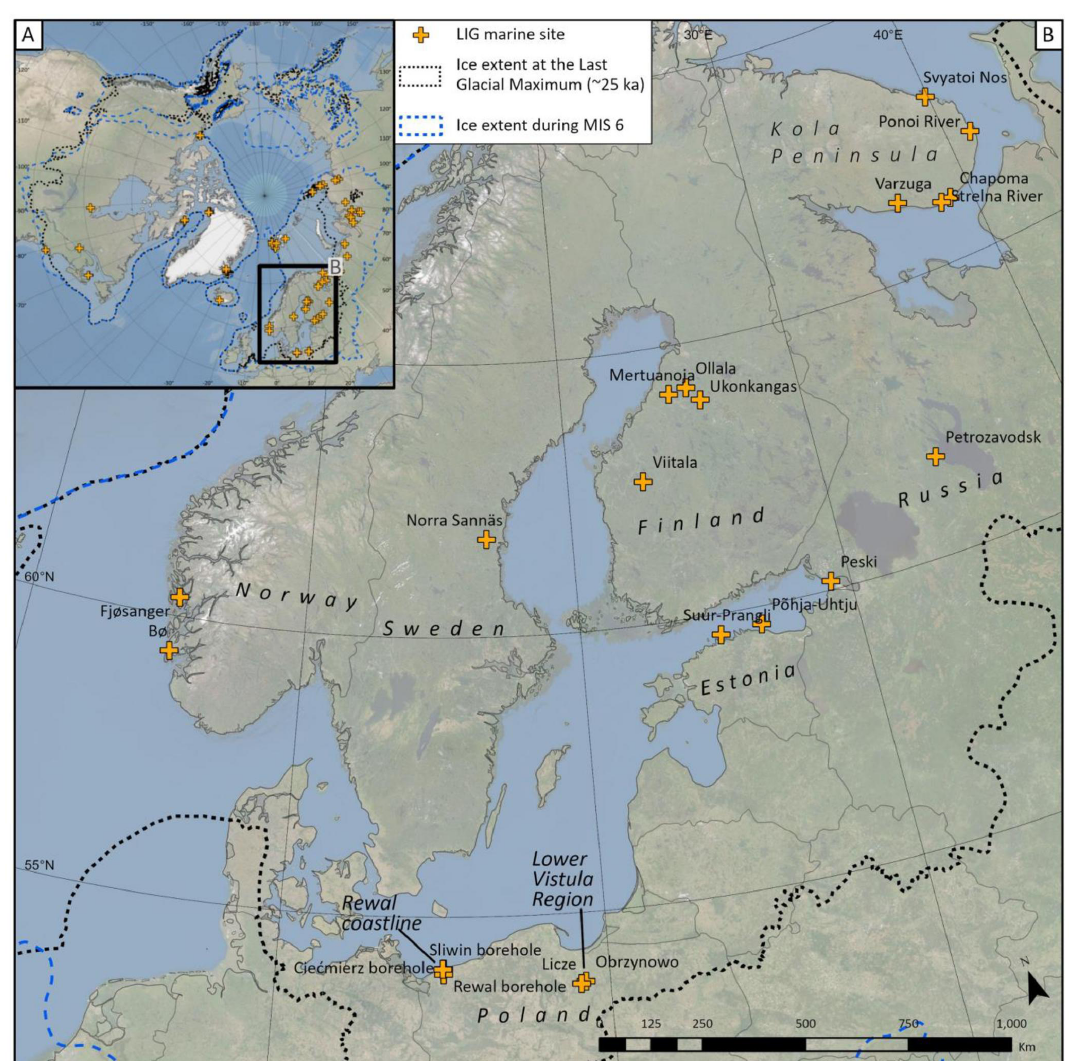
Figure 6. The location of LIG marine sites in western Russia, Estonia, Poland, Finland, Sweden and Norway. Panel (a) situates the sites in the Northern Hemisphere, whereas panel (b) provides a regional map. Sites plotted on this map are detailed in Sect. 6.16–6.33. Extent of MIS 6 and Last Glacial Maximum ice sheets after Batchelor et al. (2019). Scale calculated at centre of mapped area. Base layer: ArcGIS World